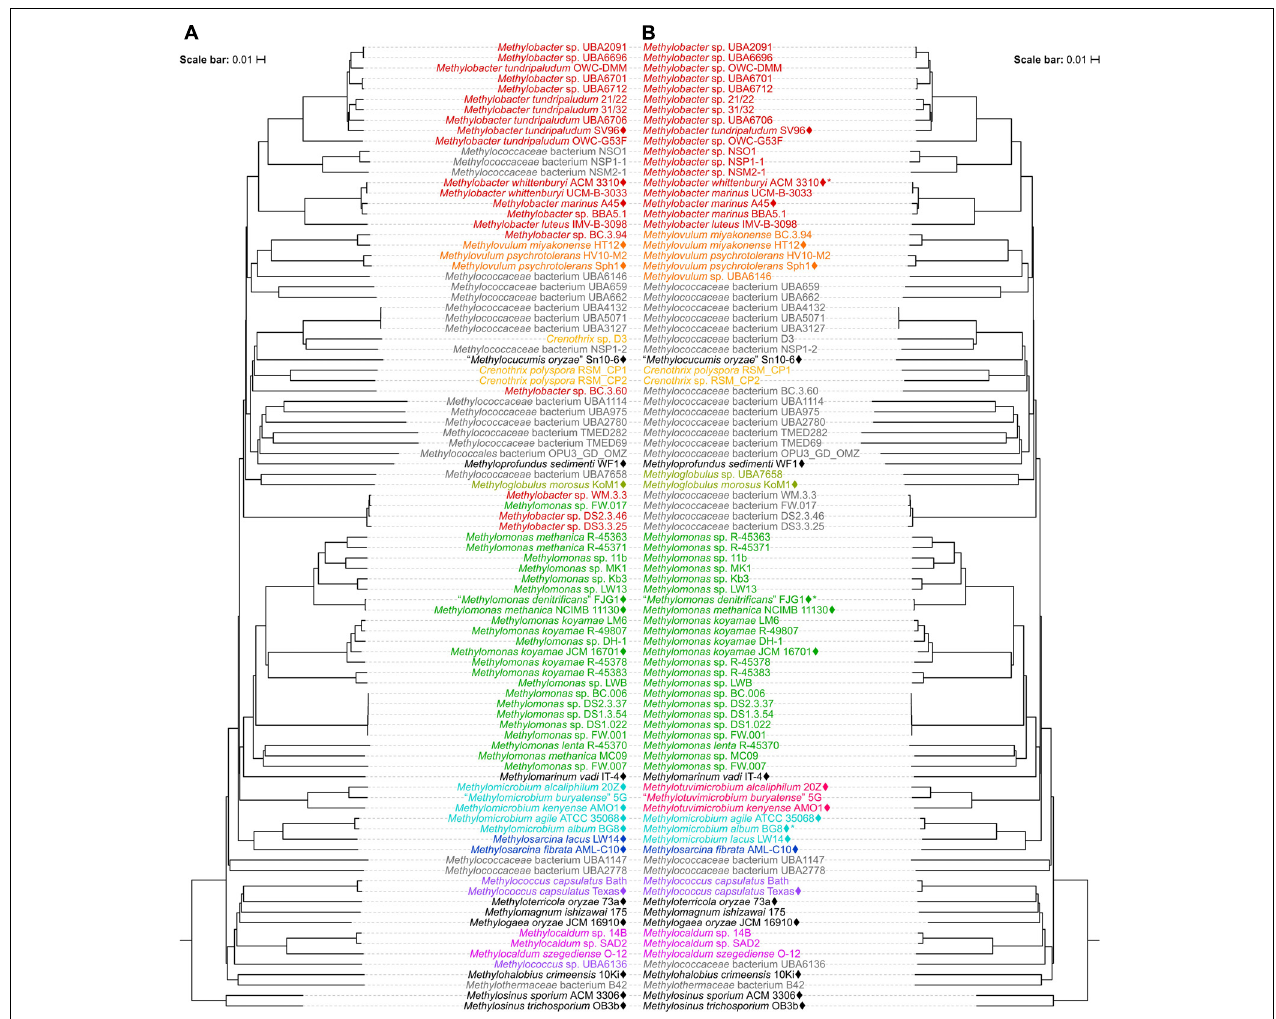
FIGURE 5 | Reclassification of the Methylococcales genomes. The phylogenetic trees are the same trees as in Figure 2 (mirror image). Names and genera (colored when containing at least two members) are shown (A) before and (B) after reclassifications. (B) Asterisks indicate later heterotypic synonyms of their senior counterparts in the same species clusters as shown in Figure 2